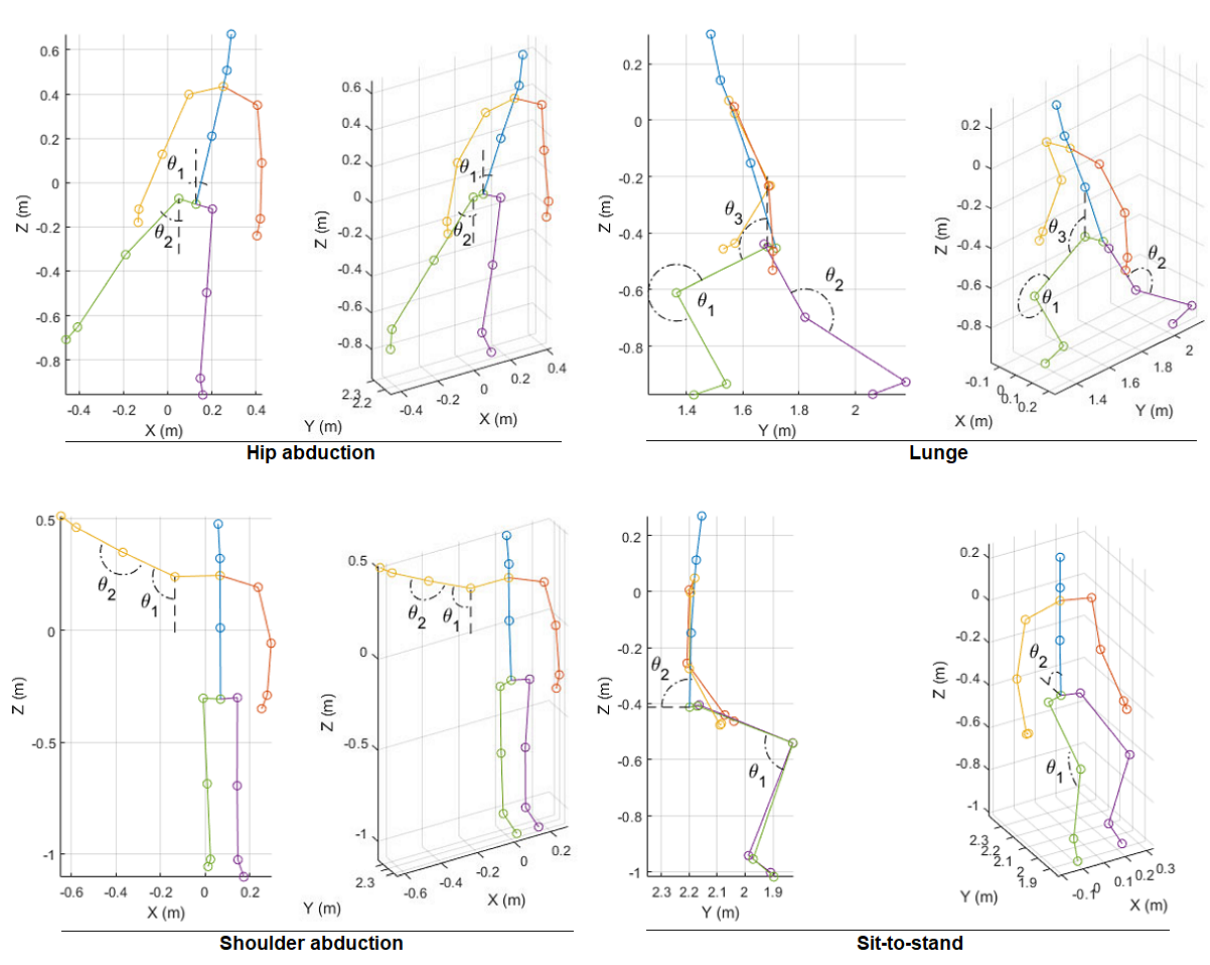
Figure 3. Extracted features (joint angles) from the joint 3D positions for each type of exercise. Both 2D side view and 3D perspective view are provided for clarity. 2D: 2-dimensional; 3D: